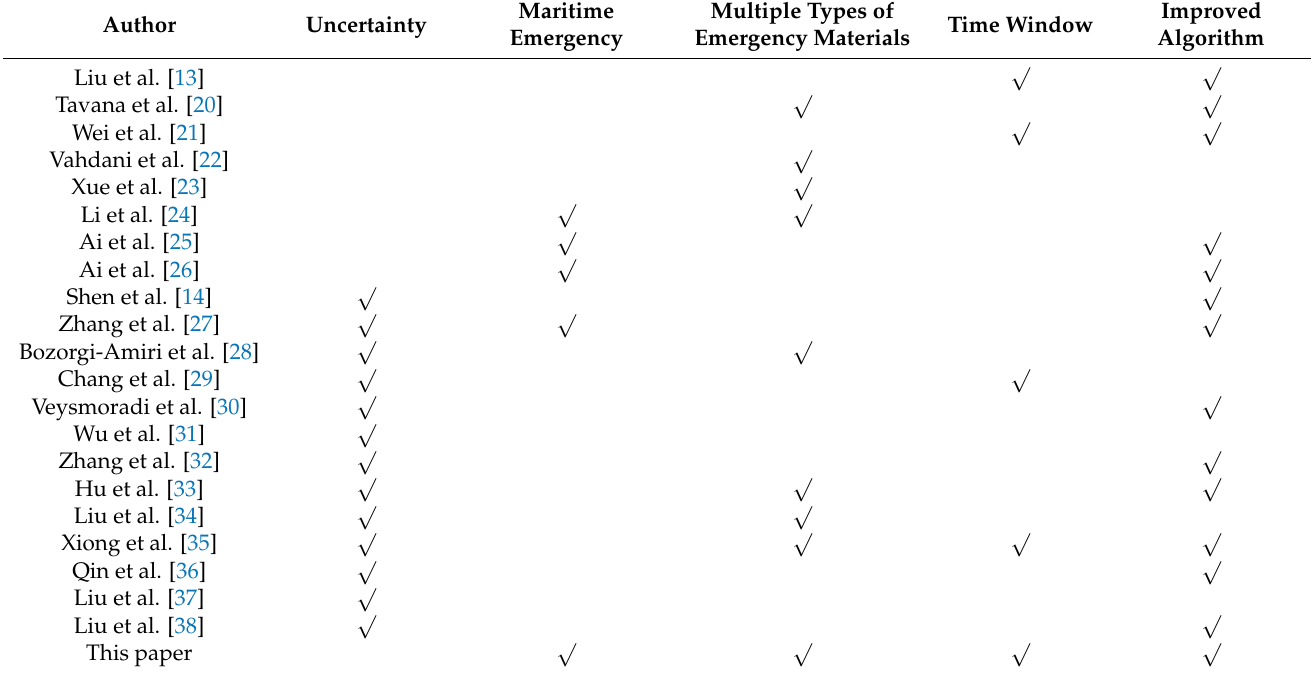
Table 1. Summary of main features of related research on emergency logistics